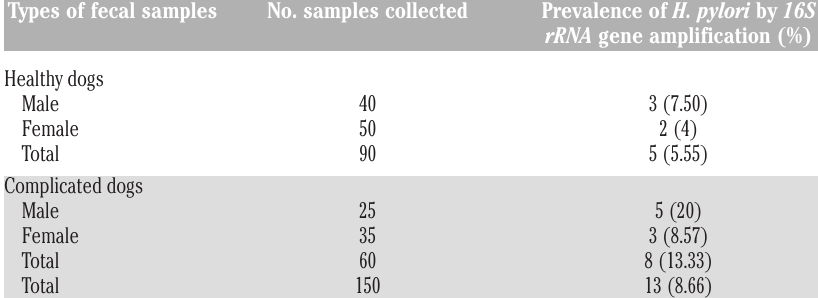
Table 2. Prevalence of Helicobacter pylori in different types of fecal samples taken from dogs.